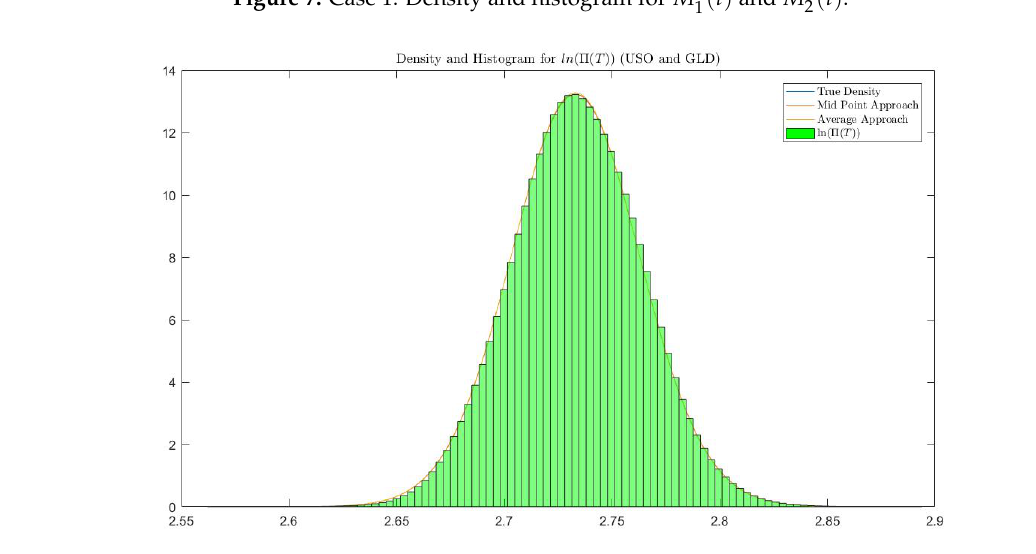
Figure 7. Case 1: Density and histogram for ˜ M ∗